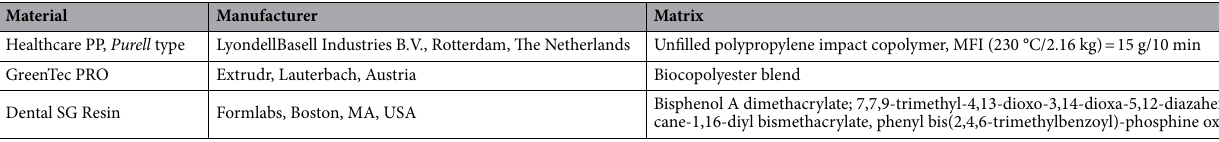
Table 1. Brand names, manufacturers, and composition according to the